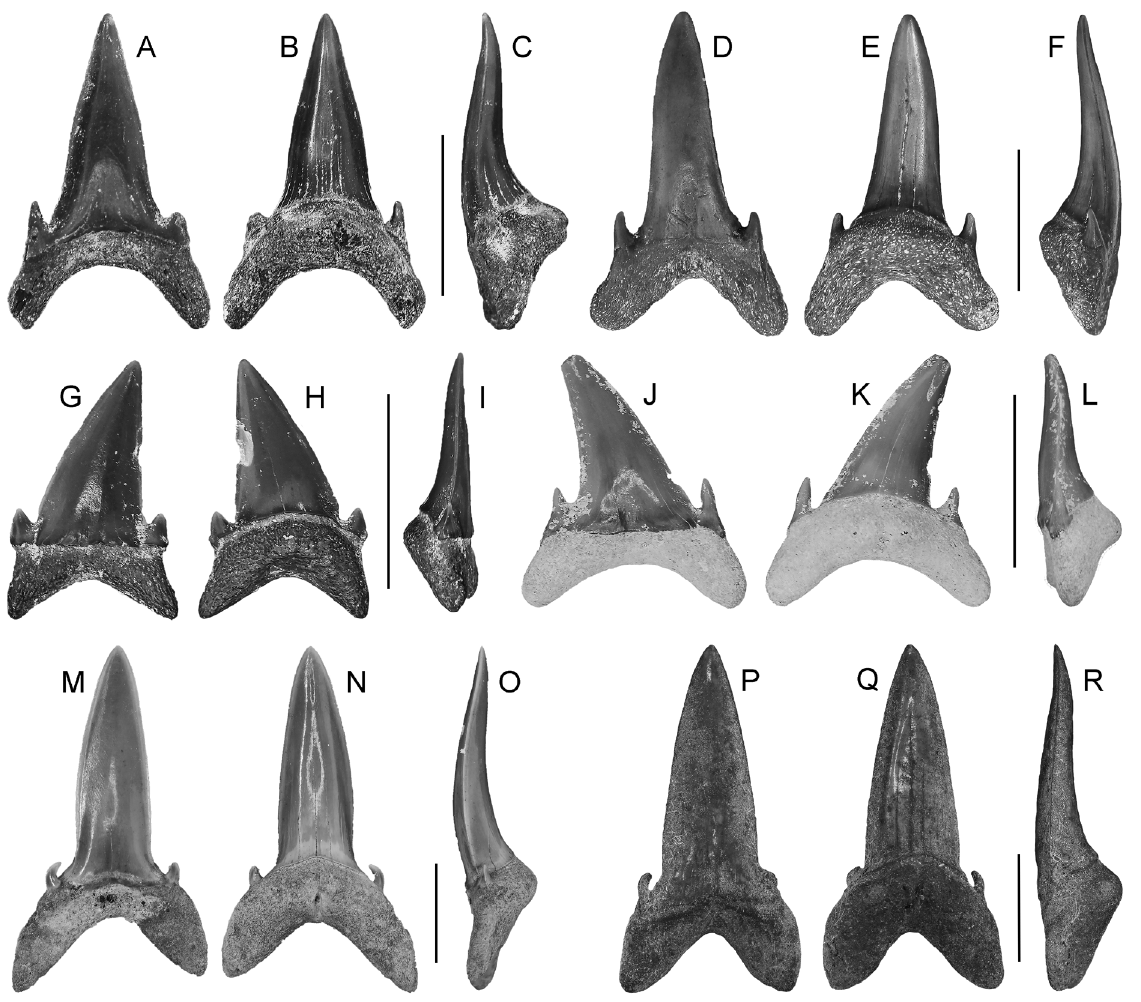
Fig. 15. Hypotodus verticalis (Agassiz, 1843), teeth. A–C . MSC 37055.1, anterior tooth, Meridian Sand Member of the Tallahatta Formation. A . Labial view. B . Lingual view. C . Mesial view. D–F . MSC 33908, anterior tooth, lower Tallahatta Formation. D . Labial view. E . Lingual view. F . Distal view. G–I . MSC 37296, lateral tooth, basal Lisbon Formation. G . Labial view. H . Lingual view. I .